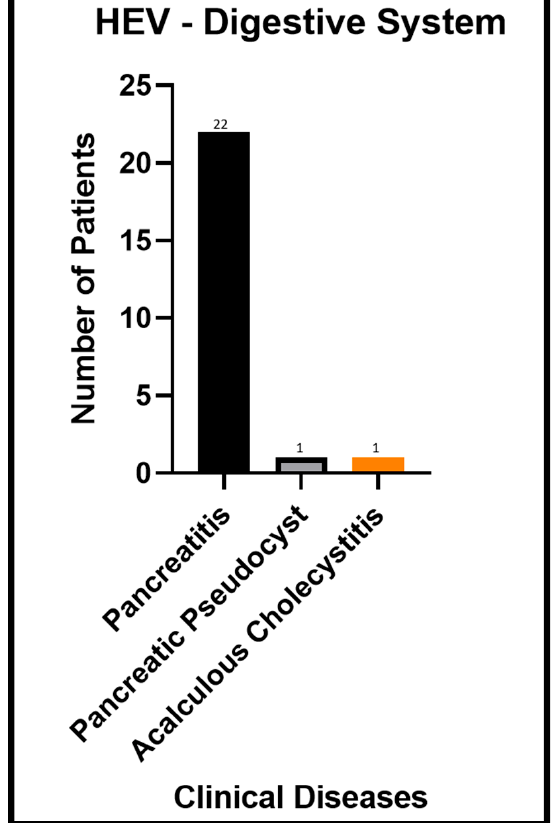
Figure 3. Summary of the digestive clinical disorders presented in relation to HEV infection. The numbers are isolated from case reports, retrospective studies, case-control studies, case series, and cross-sectional studies. Every disorder and their references were listed in Table 3.